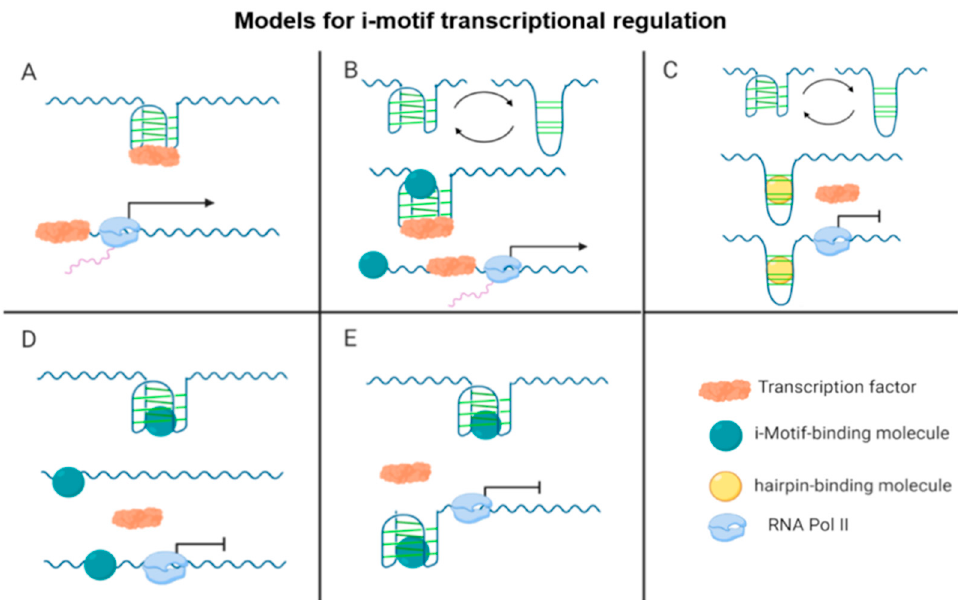
Figure 2. Schematic of the different working models for i-motif function in transcription. ( A ) An i-motif serves as a scaffold for transcription factor binding that leads to i-motif unfolding and transcriptional activation and ( B – E ) depict potential effects of i-motif-binding molecules. A small molecule can: ( B ) stabilize the i-motif over a hairpin structure, allowing transcription factor recognition of binding sites on the lateral loops of the i-motif, leading to i-motif unfolding and transcriptional activation; ( C ) bind to a hairpin structure, preventing i-motif formation, resulting in loss of transcription factor binding, and transcriptional repression; ( D ) destabilize the i-motif, leading to i-motif unfolding, loss of transcription factor binding, and transcriptional repression; or ( E ) stabilize the i-motif blocking the transcription factor binding site, leading to transcriptional repression.